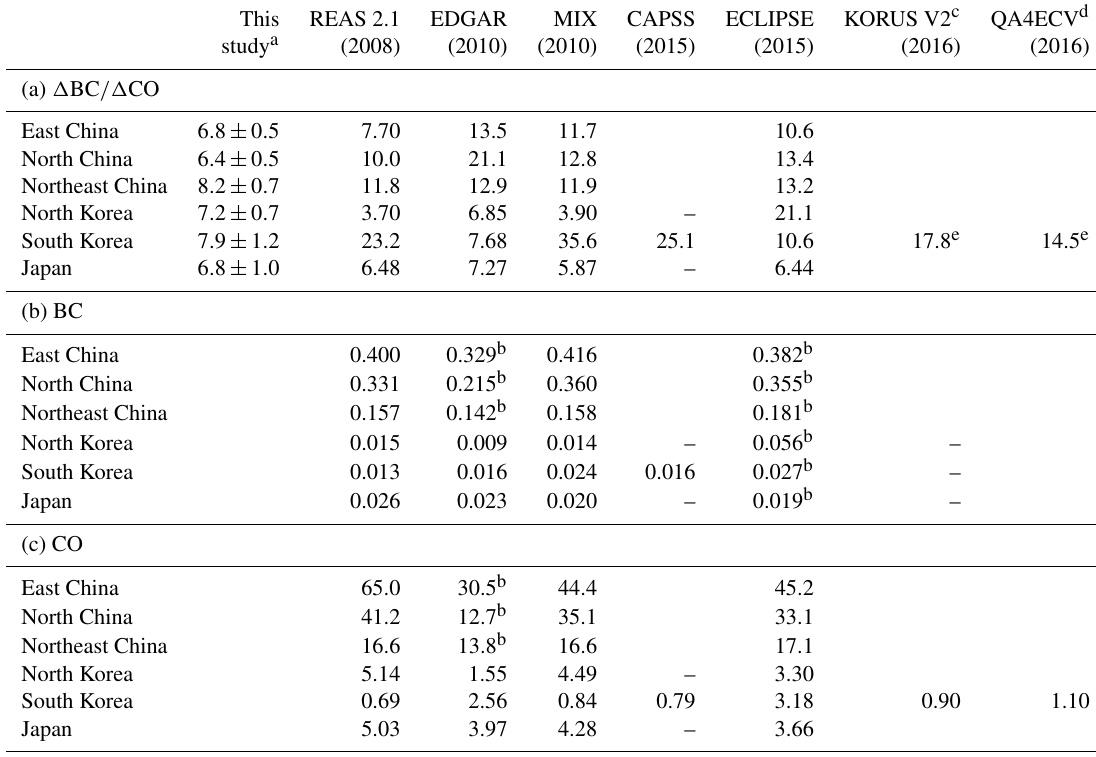
Table 3. (a) Regional (cid:49) BC /(cid:49) CO (ngm − 3 ppb − 1 ) ratios and emission rates of (b) BC and (c) CO (inTg per year) over East Asia from various emission